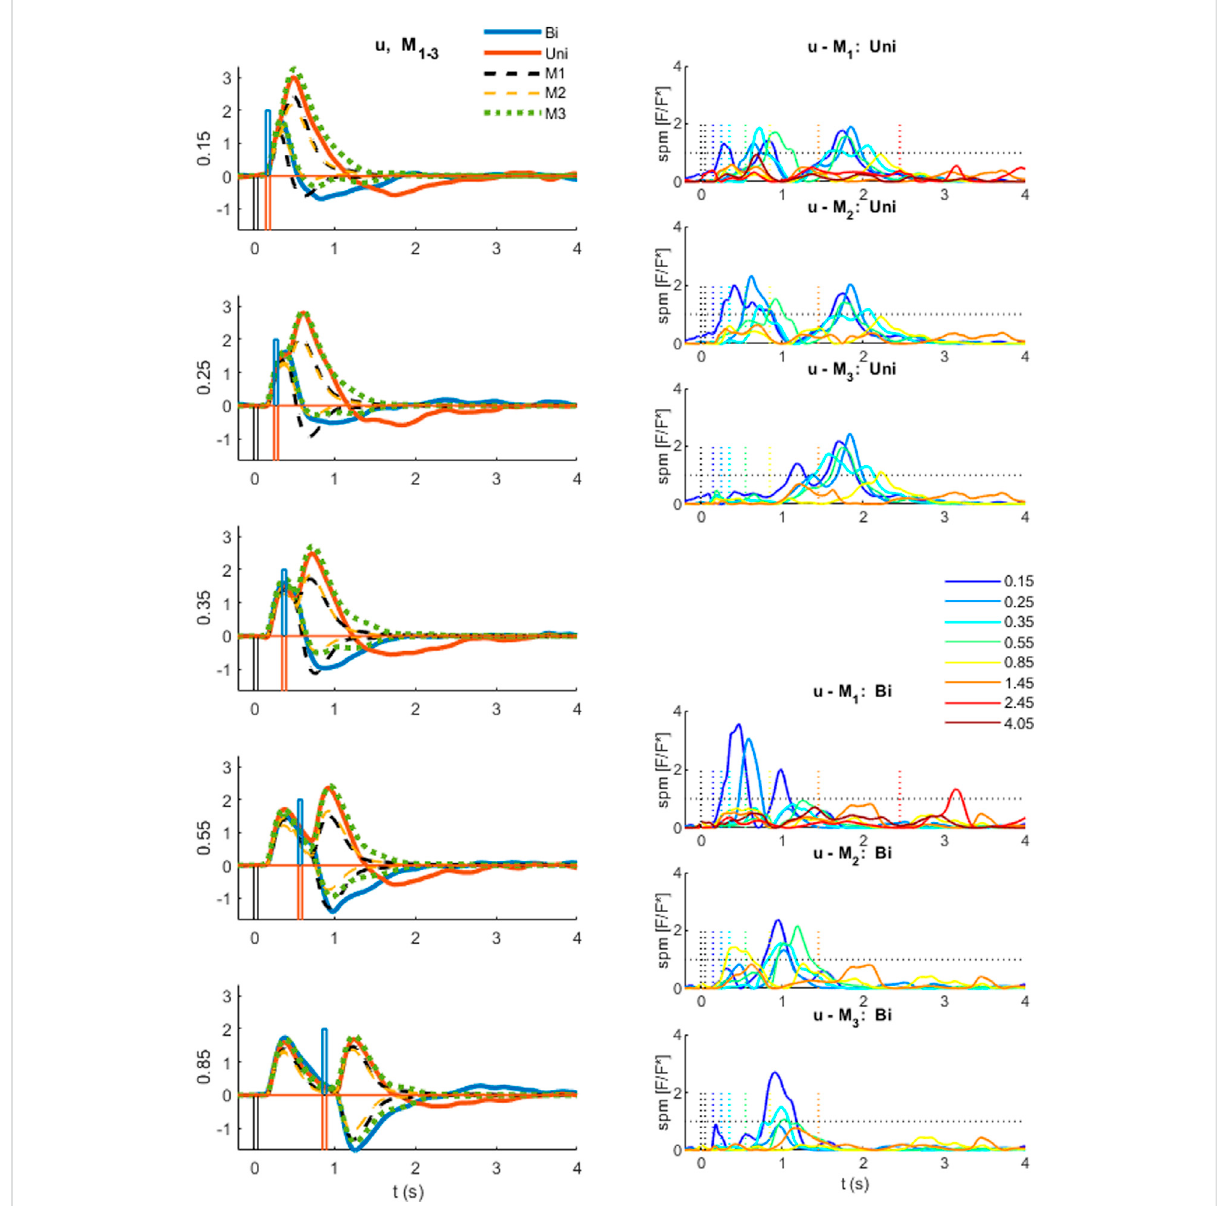
ComparisonofexperimentalcontrolsignaluwithmodelsM1-3.Left:Experimentalmyoelectriccontrolsignal(u)forBidirectional(blue)andUni directional (red) paired stimuli. Single process, LTI Model M1 (black dashed). Single process varying amplitude model M2 (yellow dashed). Two process( fi xedandvariabledelay)modelM3(greendotted).ImpulseStimuli(rectangularlines).Allsignalsaveragedoverallcasesforeachsubject,and then averaged over all subjects. N.B. For all positive fi rst stimuli, all signals reversed to align to negative fi rst stimulus and positive fi rst response. Right: Time varying Fstatisticrelativeto unitythreshold(F/F* atalpha 0.05)for all ISIintervals. Uni directional(rows 1 – 3) and Bidirectional pairs (rows 4 – 6). (1-d SPM, repeated measures Anova, n = 22). Impulse Stimuli (rectangular lines), Message: At short ISI, the two-process model M3 reproduces the experimental control signal u most